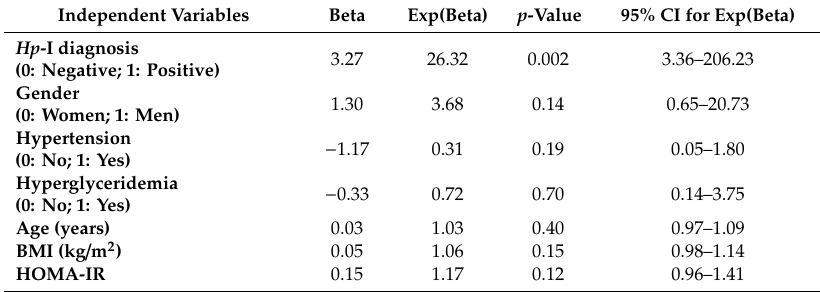
Figure 2. Liver microphotographs of patients with the most representing stages of nonalcoholic fatty liver disease. ( A ) Formalin fixed, paraffin embedded histological section (hematoxylin and eosin staining) of liver with normal architecture. ( B ) Formalin fixed, paraffin embedded histological section (hematoxylin and eosin staining) of liver with prominent steatosis without activity or fibrosis. ( C ) Formalin fixed, paraffin embedded histological section (Masson trichrome staining) of liver with bridging fibrosis. Table 1. Comparative data between Hp (+) and Hp ( − ) patients. Table 2. Independent associates of NASH (NAFL vs. NASH), according to FLIP classification in binary logistic regression analysis.